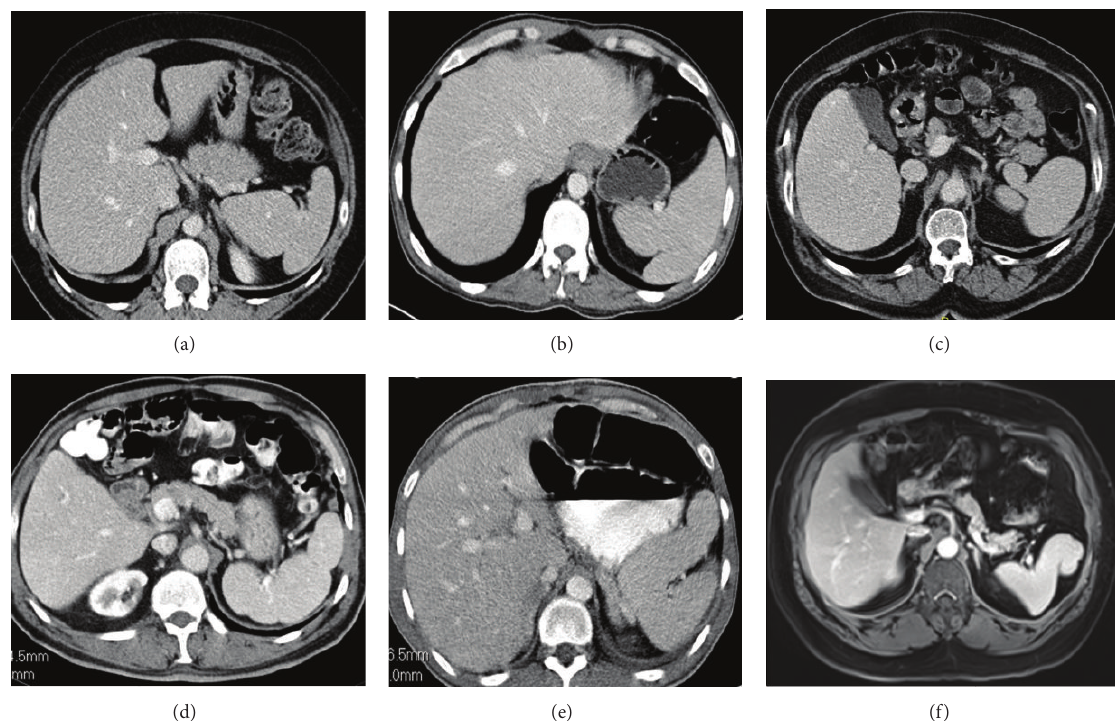
Figure 1: Axial contrast enhanced CT images (a)–(e) and post-contrast T1-weighted MR image (f) show examples of different type of persisting splenic fetal lobules and shape variations, which were incidentally detected in six different patients. Note the close relation of the medially oriented splenic lobules with upper pole of the left kidneys in (a) and